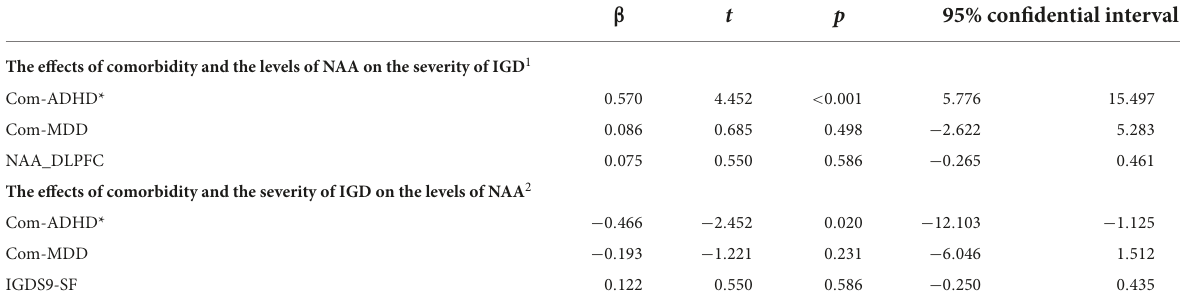
TABLE 3 Multiple linear regression analyses.